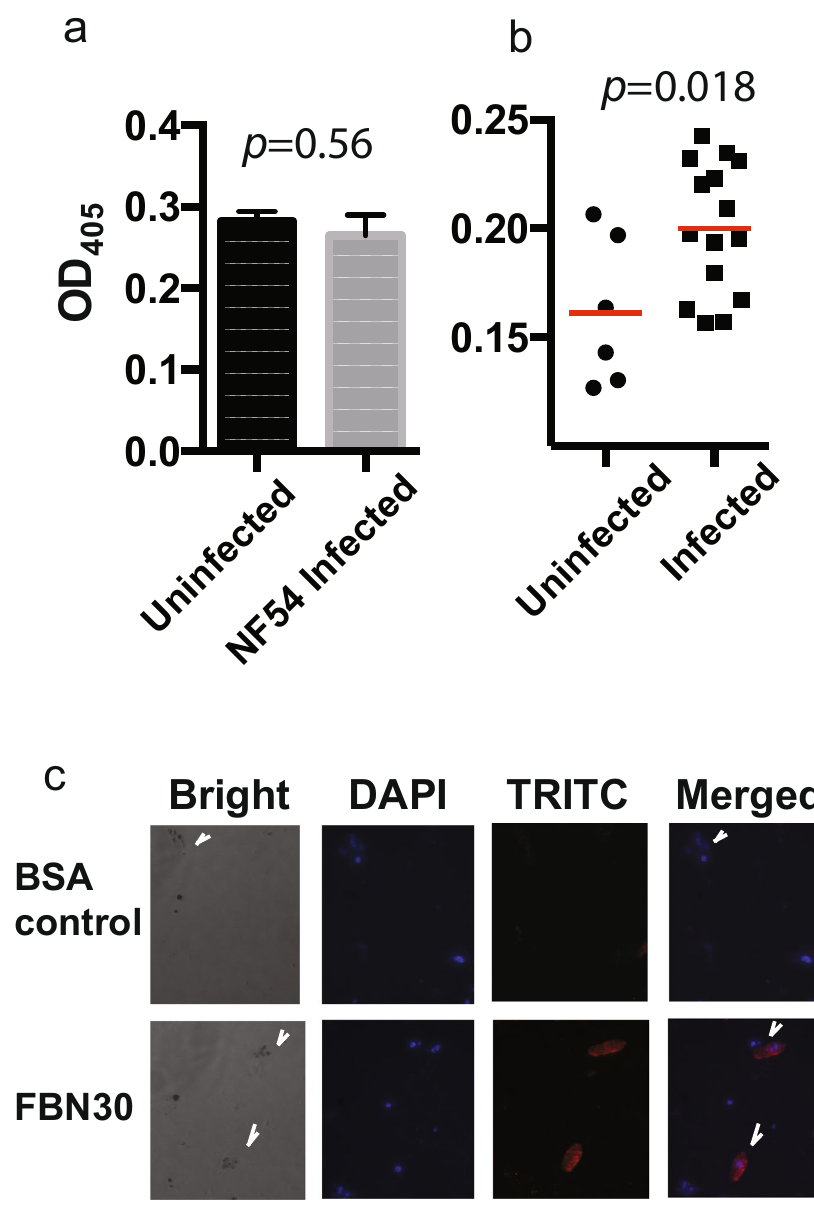
Figure 3. FBN30 interacts with clinically circulating Plasmodium falciparum isolates. ( a ) FBN30 does not bind to laboratory P. falciparum strain NF54. There is no significant difference between uninfected RBC and NF54 infected RBC in ELISA assays. ( b ) The ELISA data show that significantly more FBN30 bound to blood lysates from the malaria infected patients (15 individuals) than that from the uninfected human subjects (6 individuals) ( p = 0.018 ). ( c ) FBN30 interacts with the cultured wild type P. falciparum ookinetes determined by IFA. Images in the first row are the control group in which the anti-FBN30 was replaced with BSA. Arrows show the location of